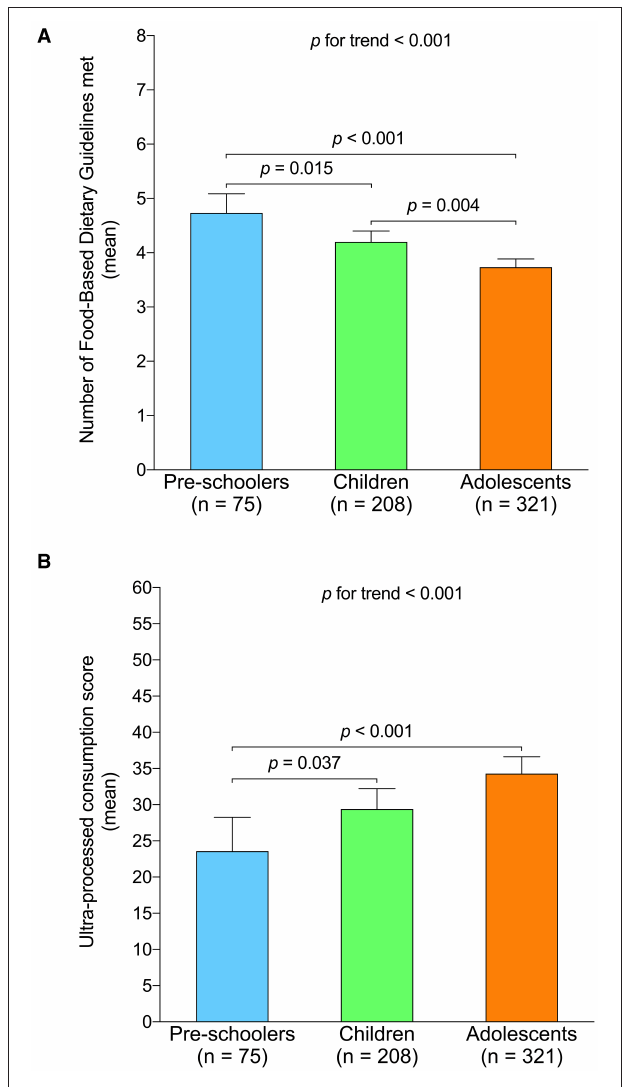
FIGURE 3 | Mean differences of the number of Food-Based Dietary Guidelines met and ultra-processed consumption score according to age group. (A) Number of Food-Based Dietary Guidelines met. (B) Ultra-processed consumption score. Adjusted by sex, socioeconomic status, educational level, geographical location, body mass index (z-score), and physical activity